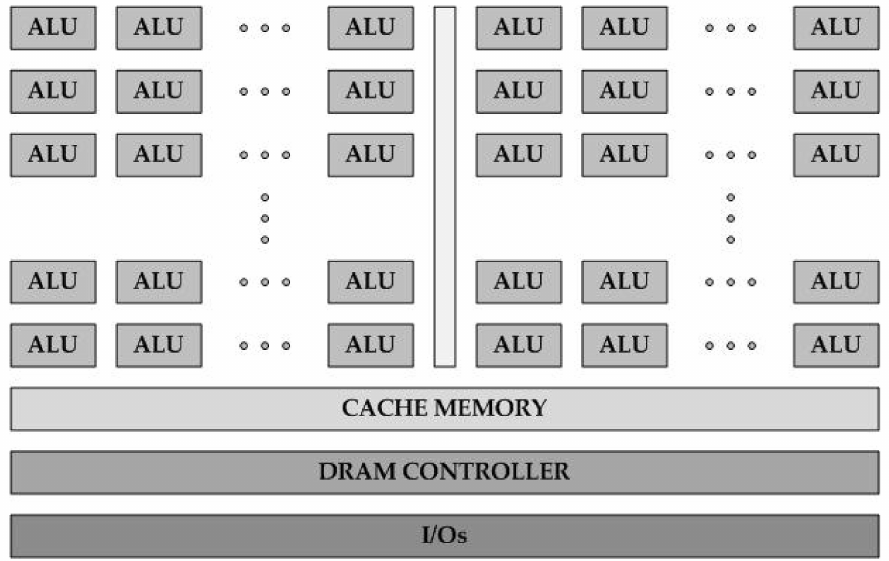
Figure 5. GPU internal